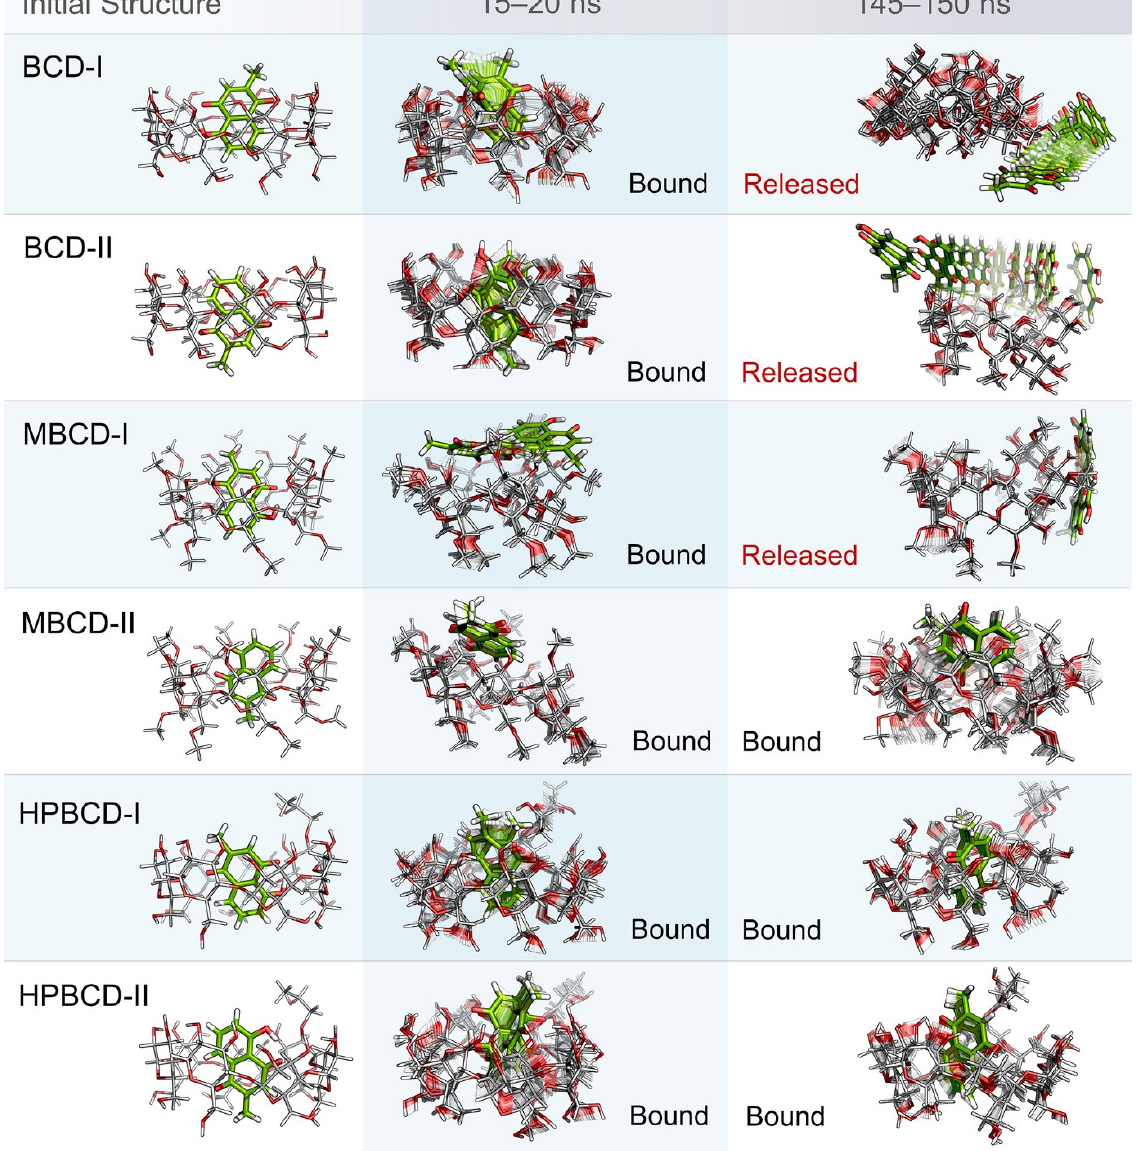
Figure 3. Illustrations of initial inclusion complex structures and dynamic snapshots from two stable intervals. Plumbagin and BCDs molecules are presented as green and light gray stick models, respectively. In both molecules, oxygen and hydrogen atoms are highlighted with red and white color, respectively. For dynamic snapshots, all intermediate frames are presented with the transparent model, only the first and the last frames were illustrated without transparency. Bound and released states are specified according to the positions and motions of plumbagin molecule.